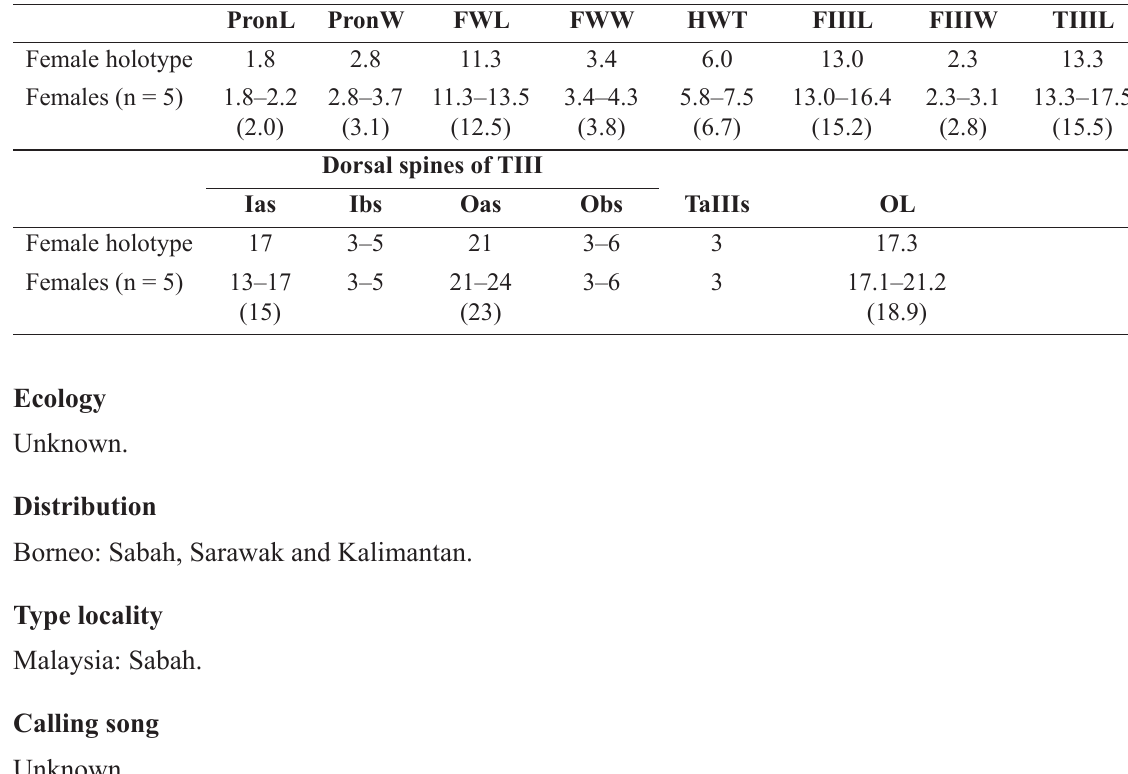
Table 10. Measurements of Nisitrus rindu Robillard & Tan sp. nov. (in mm, means in